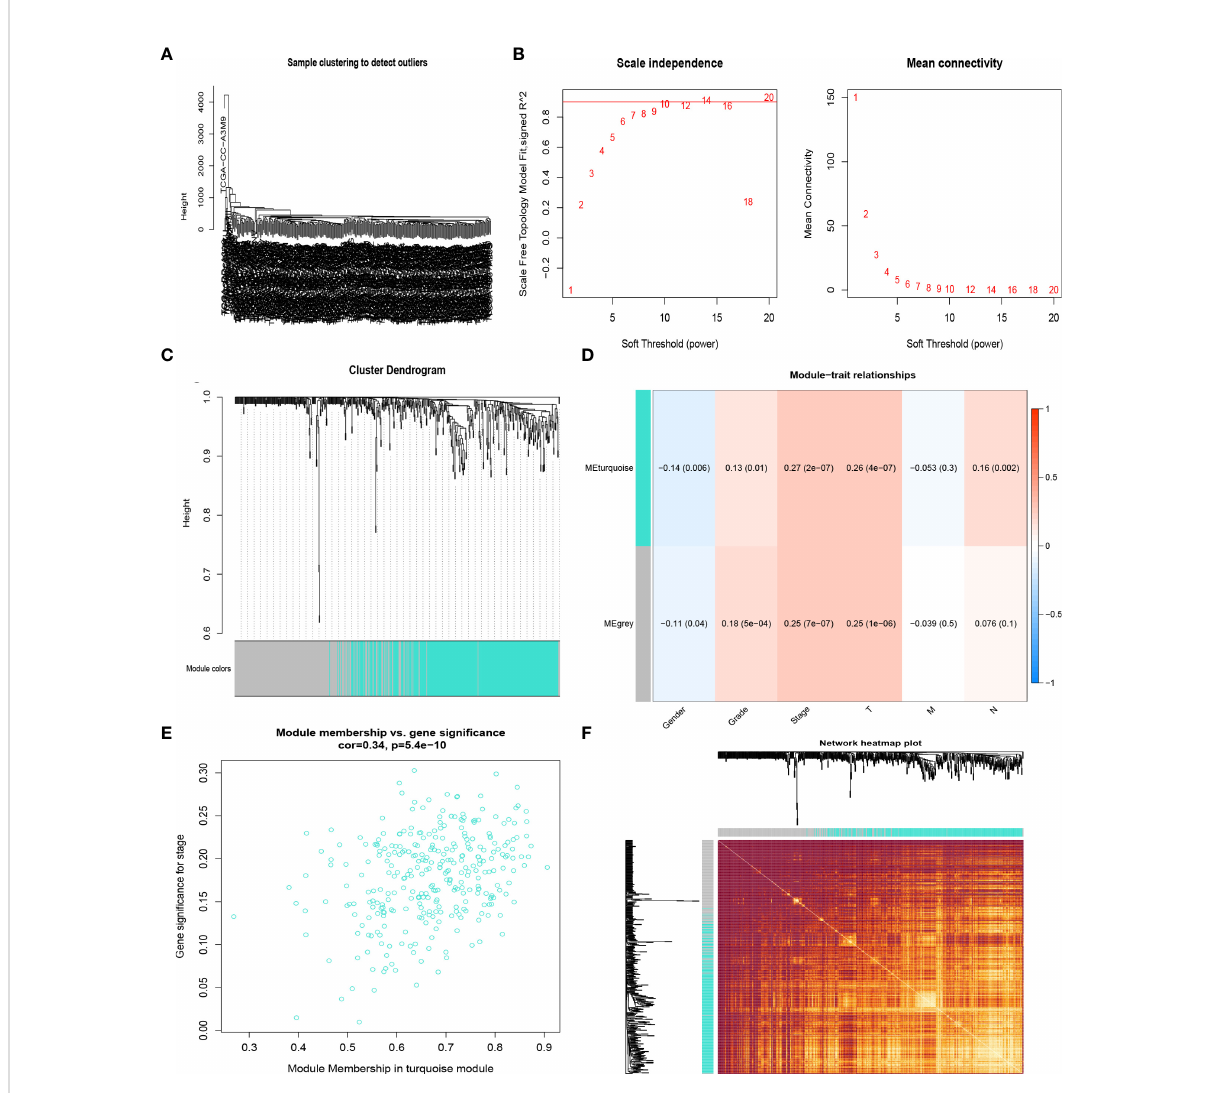
FIGURE 2 CR-related genes in the TCGA-HCC cohort by the weighted gene co-expression network analysis (WGCNA). Sample dendrogram (A) and the mean connectivity and scale independence of the WGCNA analysis (B) . Clustering dendrograms of samples in the TCGA-HCC cohort (C) . Heatmap of the correlation between module eigengenes and disease progression of HCC (D) . Scatter plot of module eigengenes in the turquoise module (E) . Heatmap describing the topological overlap matrix among genes based on co-expression modules (F)